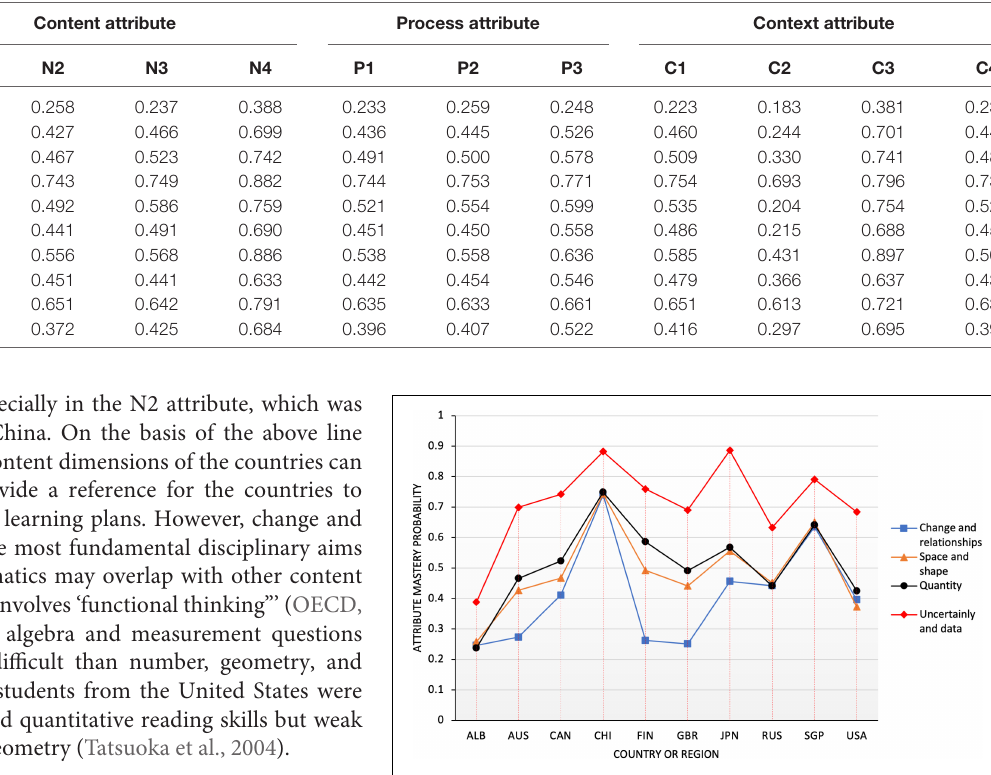
FIGURE 1 | Probability distribution map of content attributes in 10 countries.